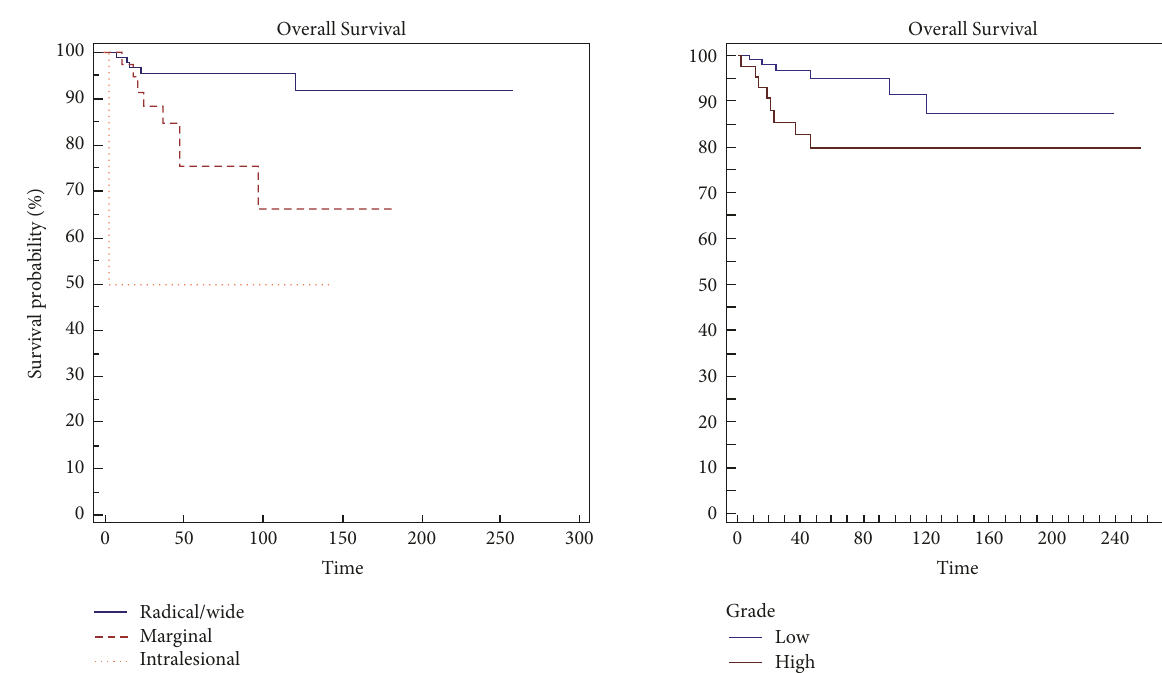
Figure 2: Grading is a significant risk factor ( 𝑝 = 0,0479) in overall survival